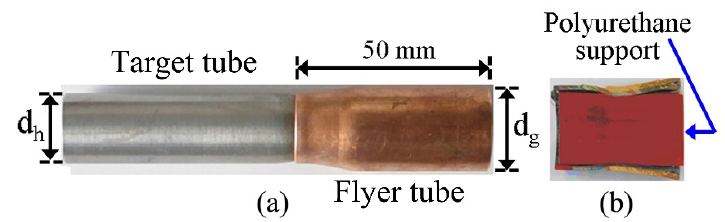
Figure 5. ( a ) Typical welded assembly and ( b ) cross-section in the as-welded condition with flyer tube diameter d g = 22.22 mm and target tube diameter d h = 16.44 to 18.44 mm.